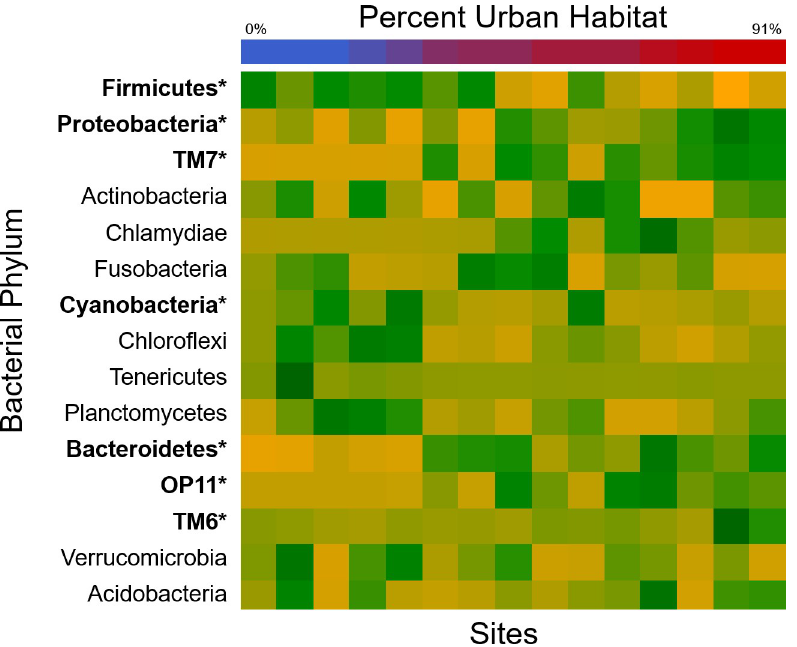
Fig 3. Correlation between urban landcover and average relative abundance of dominant bacterial phyla. The heat map shows several bacterial phyla (bolded) significantly increased (green) or decreased (yellow) in relative abundance across the urban landcover gradient (top bar, on the same color scale as Fig